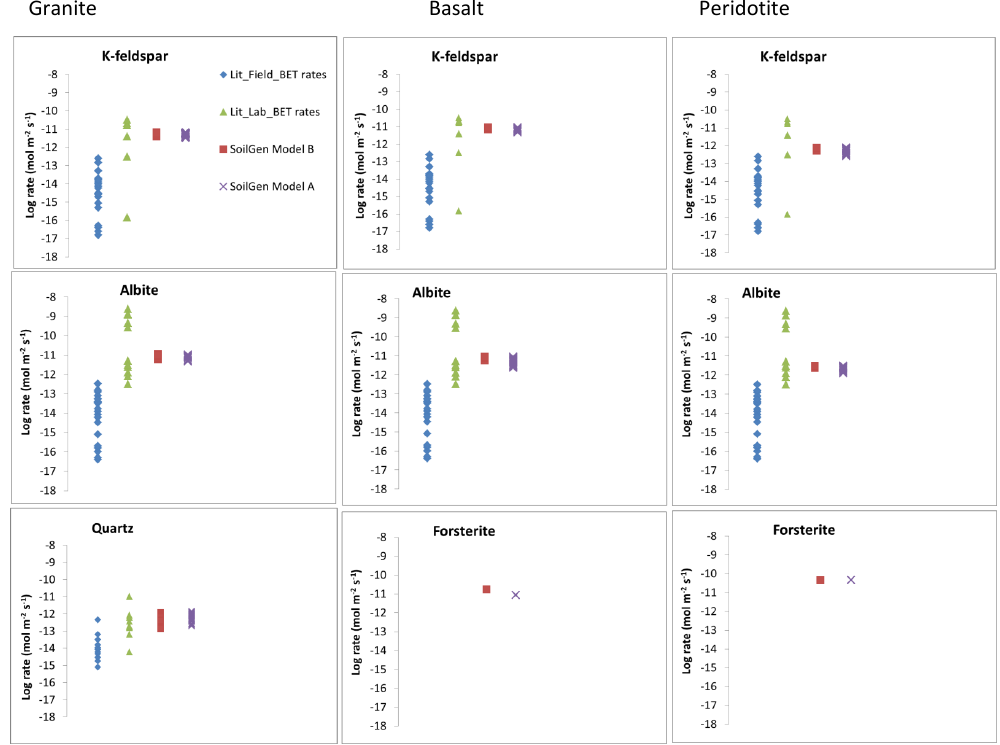
Figure 8. Comparison of SoilGen average mineral dissolution rates (Model A and Model B) to laboratory and field determined dissolution rates. Field rates were taken from Parry et al. (2015) and White (2009; Table 2) while lab rates were taken from Holdren and Speyer (1987); Siegal and Pfannkuch (1984); Swoboda-Colberg and Drever (1993); Blum and Stillings (1995), Lee et al. (1998): K-feldspar; Stillings et al. (1996); Welch and Ullman (1996); Oxburgh et al. (1994); Blum and Stillings (1995), Chou and Wollast (1985); Knauss and Wolrey (1986); Hamilton et al. (2000): Albite; Brady and Walther (1990); Dove (1994): Quartz. The same field and laboratory rates are repeated for different parent materials (Granite, Basalt and Peridotite). Laboratory and field dissolution rates for Forsterite are not